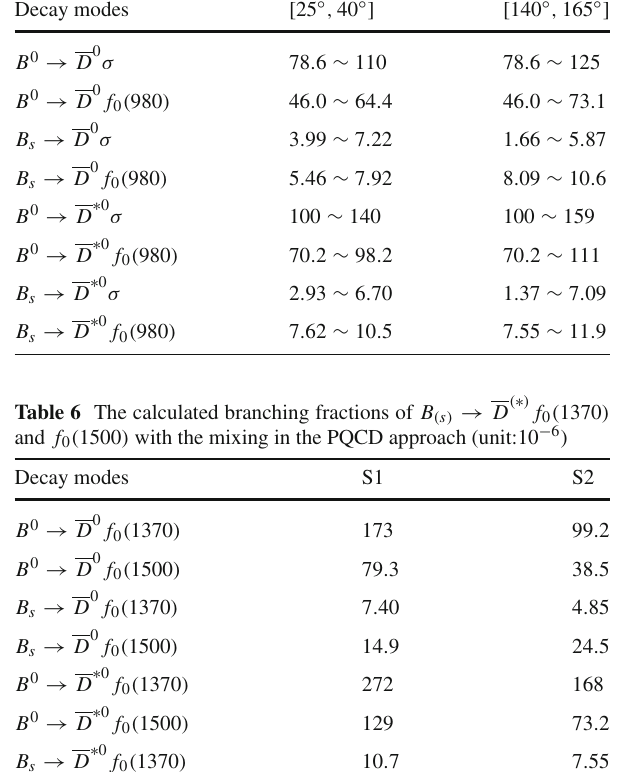
Table 5 The calculated branching fractions of B ( s ) → D and σ with the mixing in the PQCD approach (unit:10 − 6 ) Decay modes